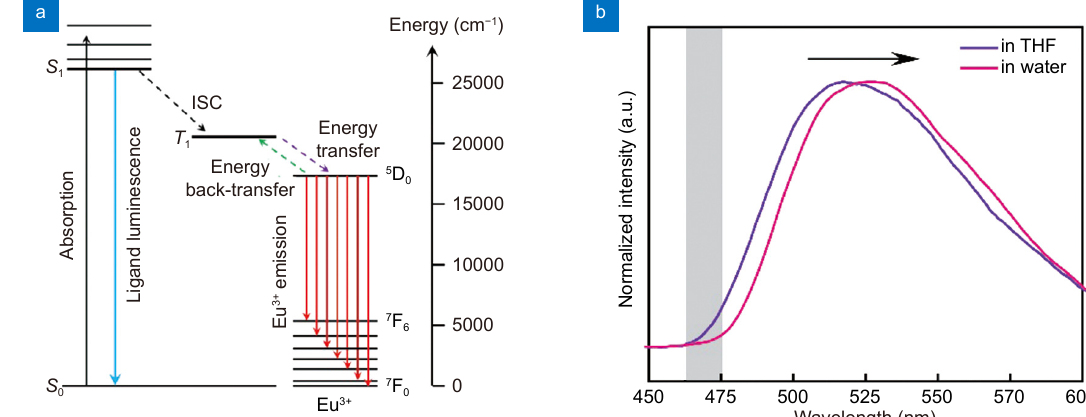
Fig. 6 | ( a ) Schematic representation of energy transfer process in Eu(BDC-NH 2 ). ( b ) Phosphorescence spectra of Gd(BDC-NH 2 ) at 77 K excited at 375 nm in frozen THF and